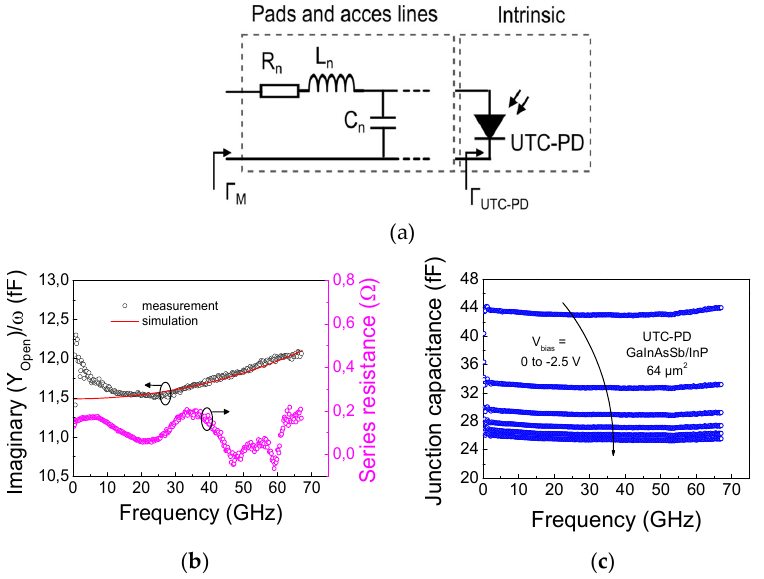
Figure 8. ( a ) Equivalent circuit of the UTC-PD connected to cascaded pads and access lines ( b ) extracted parasitic elements associated with the Pads and access lines ( c ) extracted UTC-PD junction capacitances at various reverse bias. Table 3. Extracted RLC lumped elements values from GaInAsSb/InP UTC-PD Open and Short test structures.